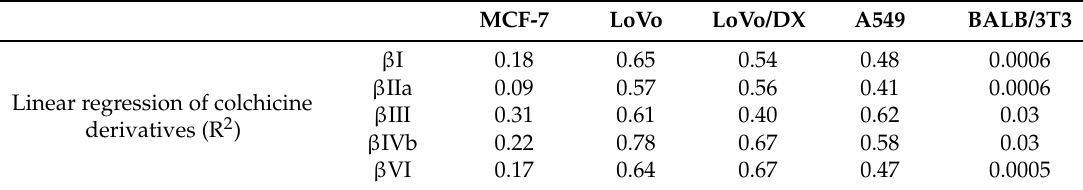
Table 5. Linear regressions involving two independent variables (binding energy by MM/PBSA method and MlogP) of the investigated colchicine derivatives versus log IC 50 ( µ M) in different cancer cell lines.